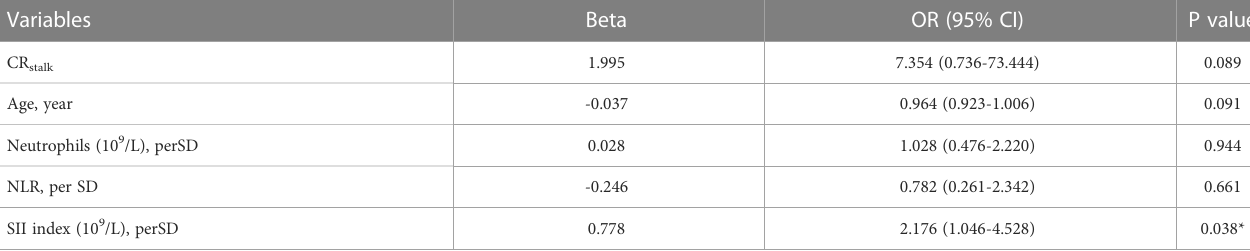
TABLE 4 Multivariable analysis for predictors associated with aneurysmal